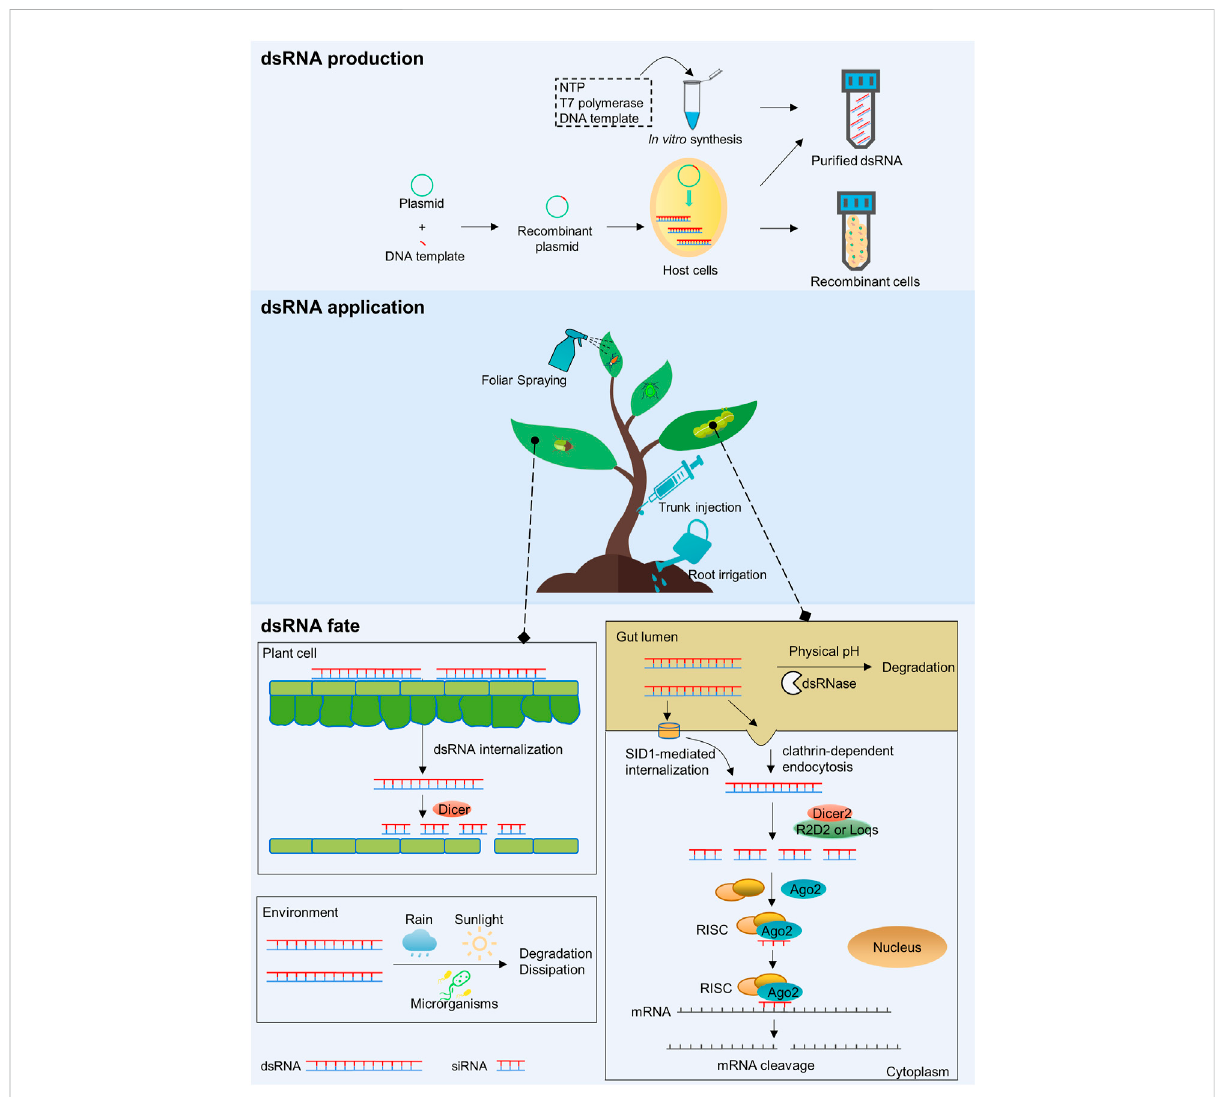
FIGURE 1 The schematic diagram of production, application and the fate of